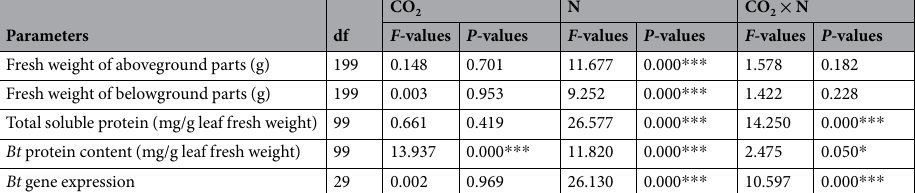
expression (35.31%) at the lowest N-fertilizer rate (i.e., 1/8 N) while significantly up-regulated the Bt -transgene expression (75.13%) at the highest N-fertilizer rate (i.e., 2 N) (Fig. 5). Methylation status of Bt-transgene of transgenic Bt rice leaves. The methylation status of Bt trans- gene (i.e., Cry1Ab / Ac fusion gene) transferred to rice plant showed uneven methylation under different combina- tion treatments of CO 2 concentration and N-fertilizer supply (Fig. 6A). Different N supply showed various effects towards the methylation of Bt -transgene body. Under ambient CO 2 , lowest and highest methylation percentages were observed at 1/8 N (1.28% of cytosines) and 1/4 N (4.01% of cytosines), respectively; methylation was stabi- lized at ½ N to 2 N range (2.06% at 1 N level to 2.38% at ½ N level of cytosines). In contrast, under elevated CO 2 , the methylation status showed declining tendency at sub-optimal levels of N (3.18% to 0.64% of cytosines), and then it moved to a hypermethylation status at 2 N level (2.67% of cytosines) (Fig. 6A). Furthermore, at severe nitrogen-deficit (1/8 N) and excessive nitrogen fertility (2 N) conditions, Bt -transgene body appeared to undergo hypermethylation under elevated CO 2 (3.18% and 2.67% of cytosines) compared to ambient CO 2 (1.28% and 2.12% of cytosines), respectively. In contrast, elevated CO 2 (2.44%, 2.04%, and 0.64% of cytosines) led lower methylation in Bt -transgene body than ambient CO 2 (4.01%, 2.38%, and 2.06% of cytosines) at intermediate N levels (i.e., 1/4, 1/2, 1 N) (Fig. 6A).